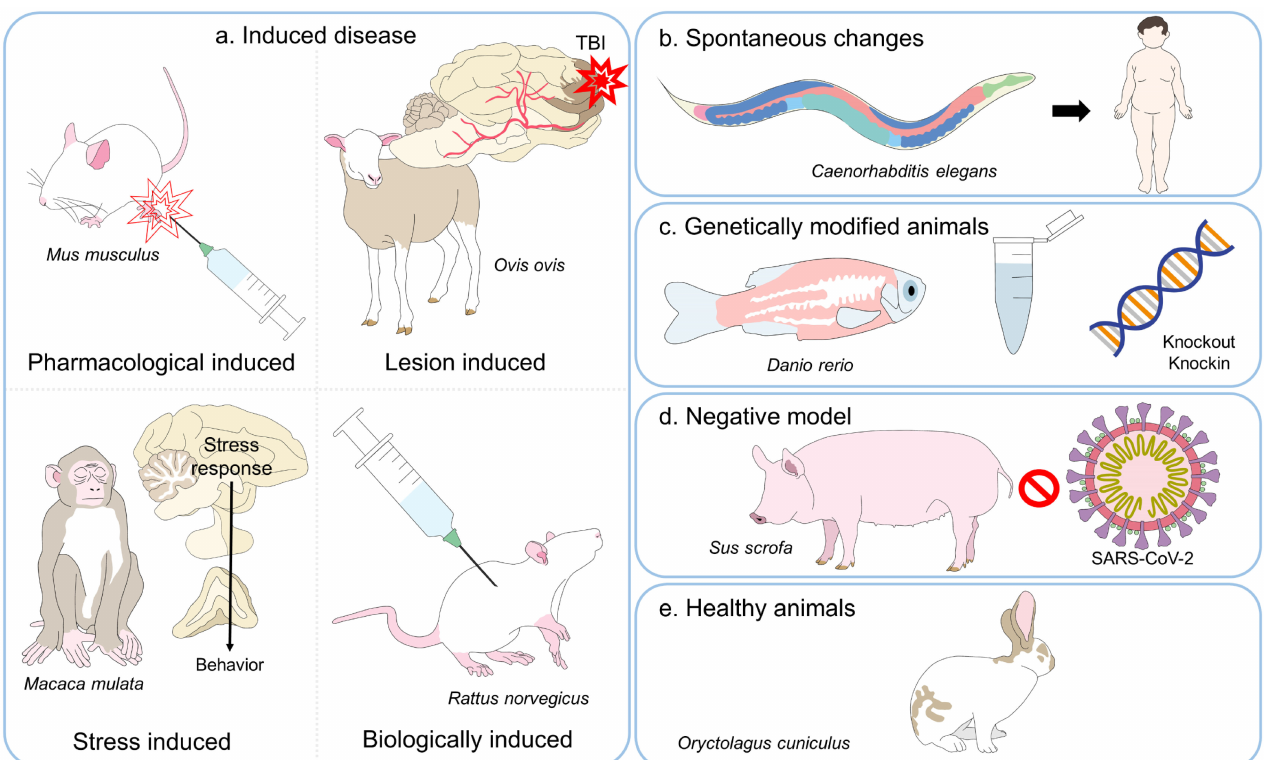
Figure 1. Classification of various animal models. The animals used in science can be divided into five broad types. ( a ) The main ones are models in which animals are induced to present a pathology similar to one that affects humans or other animals by administering drugs or other biologicals, inflicting injuries, or subjecting them to stress or other environmental conditions. In contrast, models based on spontaneous changes ( b ) include animals where the normal course of their life predisposes them to develop a specific disease. ( c ) Genetically-modified test subjects are animals with knockin or knockout genes or proteins. In contrast to using healthy animals ( e ), negative models ( d ) employ individuals that are not susceptible to certain diseases but serve to evaluate susceptibility to a specific pathology. TBI: traumatic brain